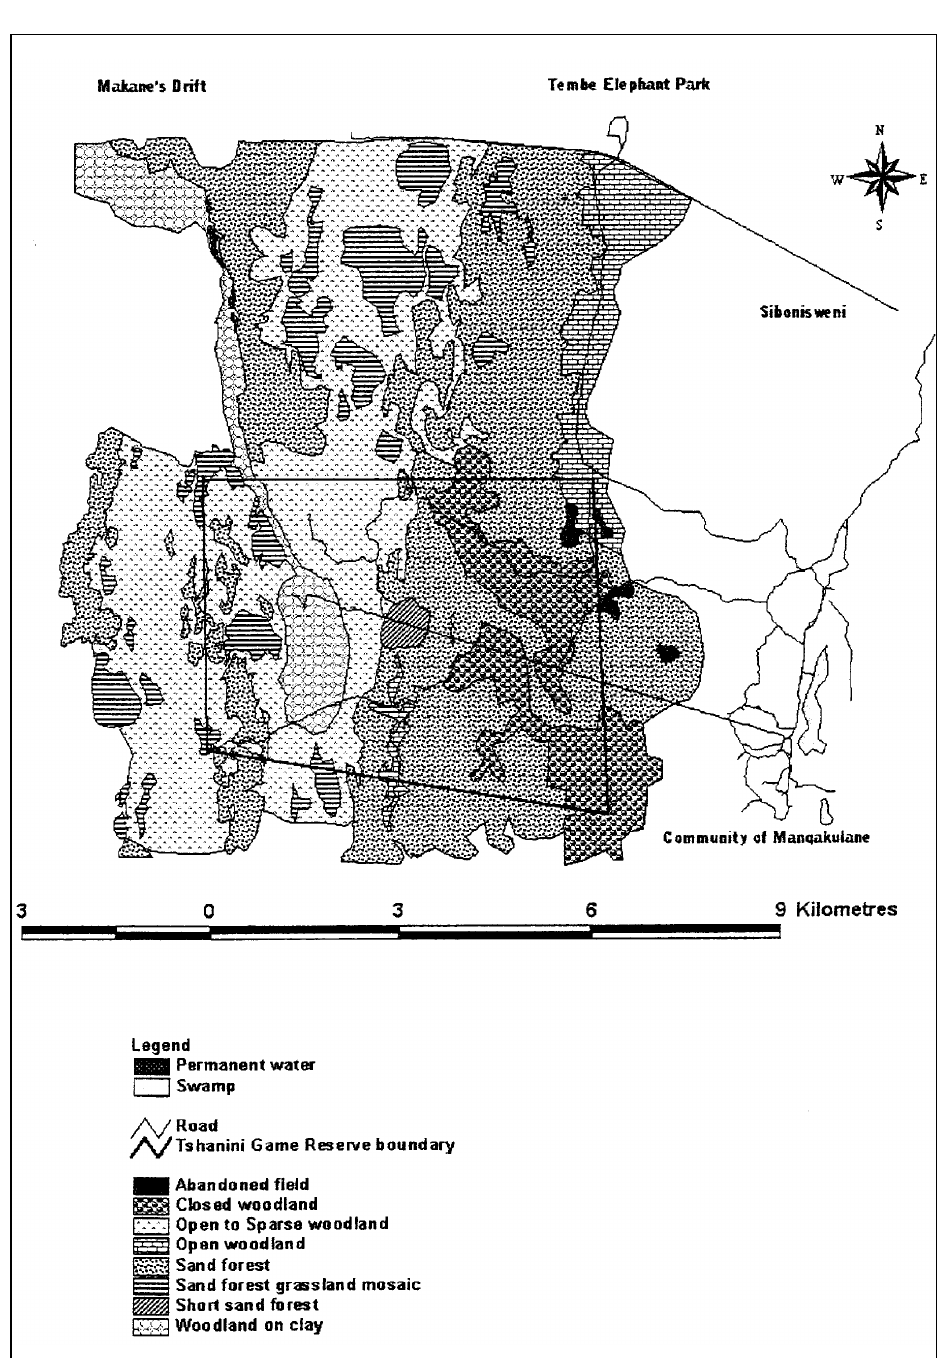
Fig. 2. The vegetation of the Tshanini Game Reserve and surrounding area in Maputaland, northern KwaZulu-Natal, South